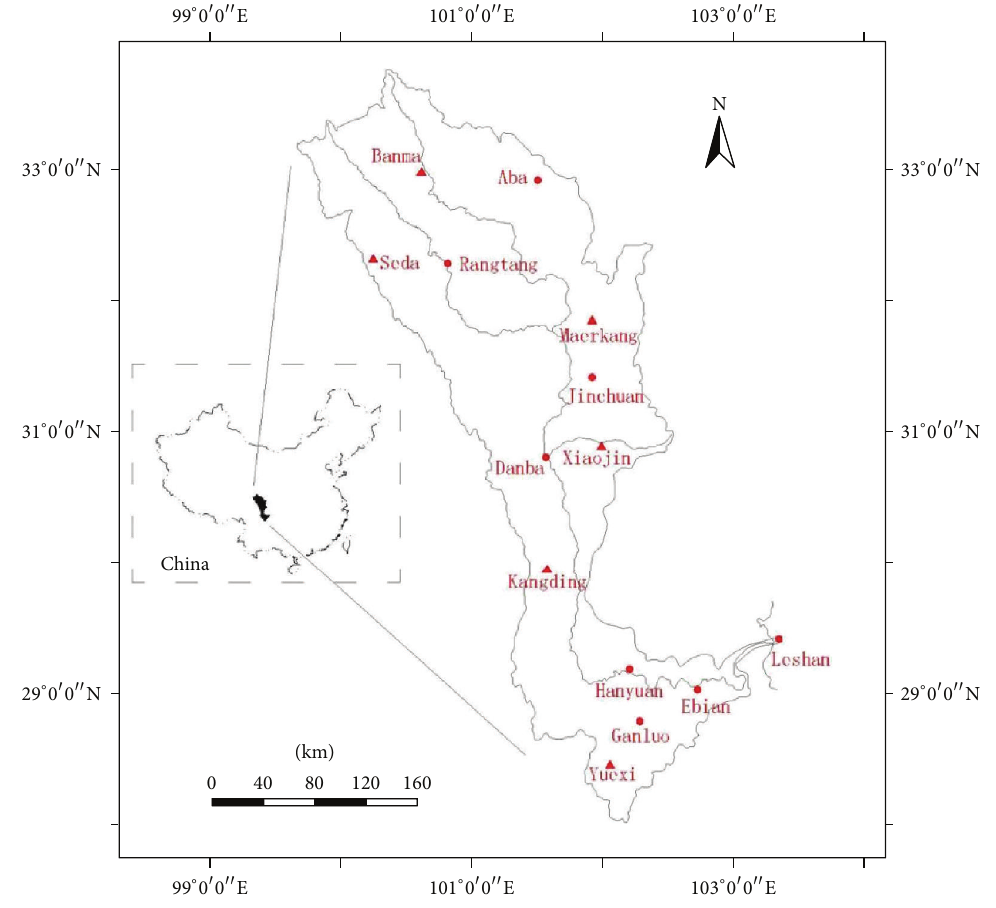
Figure 1: Sketch map of the study